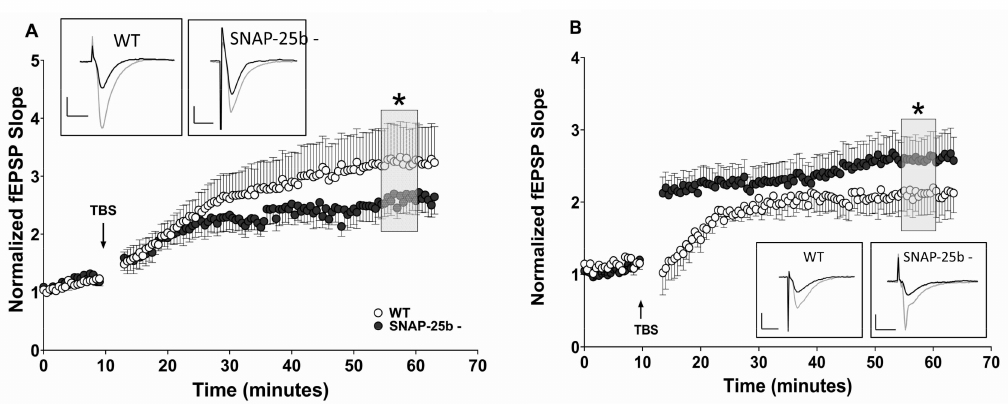
Figure 2. Alterations in stimulus-evoked LTP in SNAP-25b-deficient mice of both sexes at one and four months of age. ( A ) Theta burst stimulation (TBS)-induced LTP (burst data points not shown) at one month in hippocampal Scha ff er collateral synapses. Arrows indicate application of TBS in each panel. Young SNAP-25b deficient mice expressed lower sLTP (filled circles, n = 13) compared to age-matched controls (open circles, n = 12). (* p < 0.01; Student’s t -test). Each point is normalized to the averaged baseline and is mean ± SEM of n slices. ( B ) Time course of LTP induced by TBS in littermate controls (open circles, n = 9) and SNAP-25b-deficient mice (filled circles, n = 9) in slices from 4 month old mice. Older SNAP-25b-deficient mice show enhanced LTP with an altered PTP compared to littermate controls (* p < 0.01; Student’s t -test). Each point is normalized to the averaged baseline and is mean ± SEM of n slices. LTP was calculated as mean of grey box, compared to pre-TBS normalized baseline. Insets: Representative Scha ff er collateral-evoked fEPSPs in WT and SNAP-25b deficient slices immediately before (black traces) and 50 min after (grey traces TBS stimulation, with calibration bars in ( A ) 1mV / 10msec, in ( B ) 2mV /